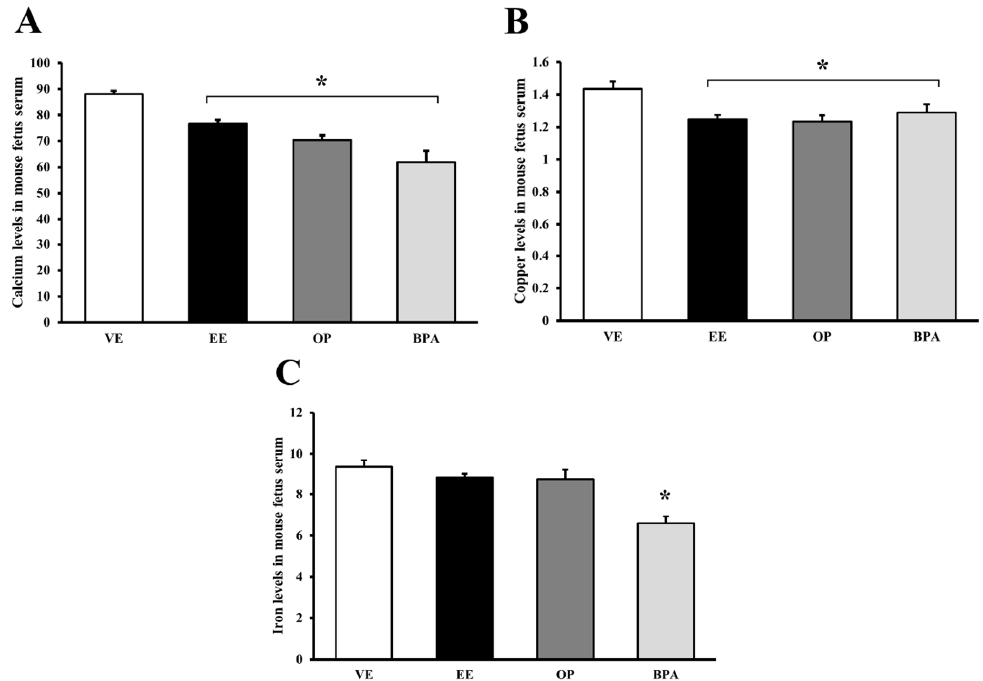
Figure 5. Alteration of cation levels in mouse fetal serum. The effects of OP and BPA were evaluated on placenta cation transporter channel during pregnancy. Calcium ( A ); copper ( B ); and iron ( C ) levels were measured using an inductively coupled plasma optical emission spectrometer (ICP-OES) in fetal serum. * p < 0.05 vs. VE. Data are presented as the mean ± SD. VE DMSO 5%, EE 0.2 mg/kg, OP, BPA 50